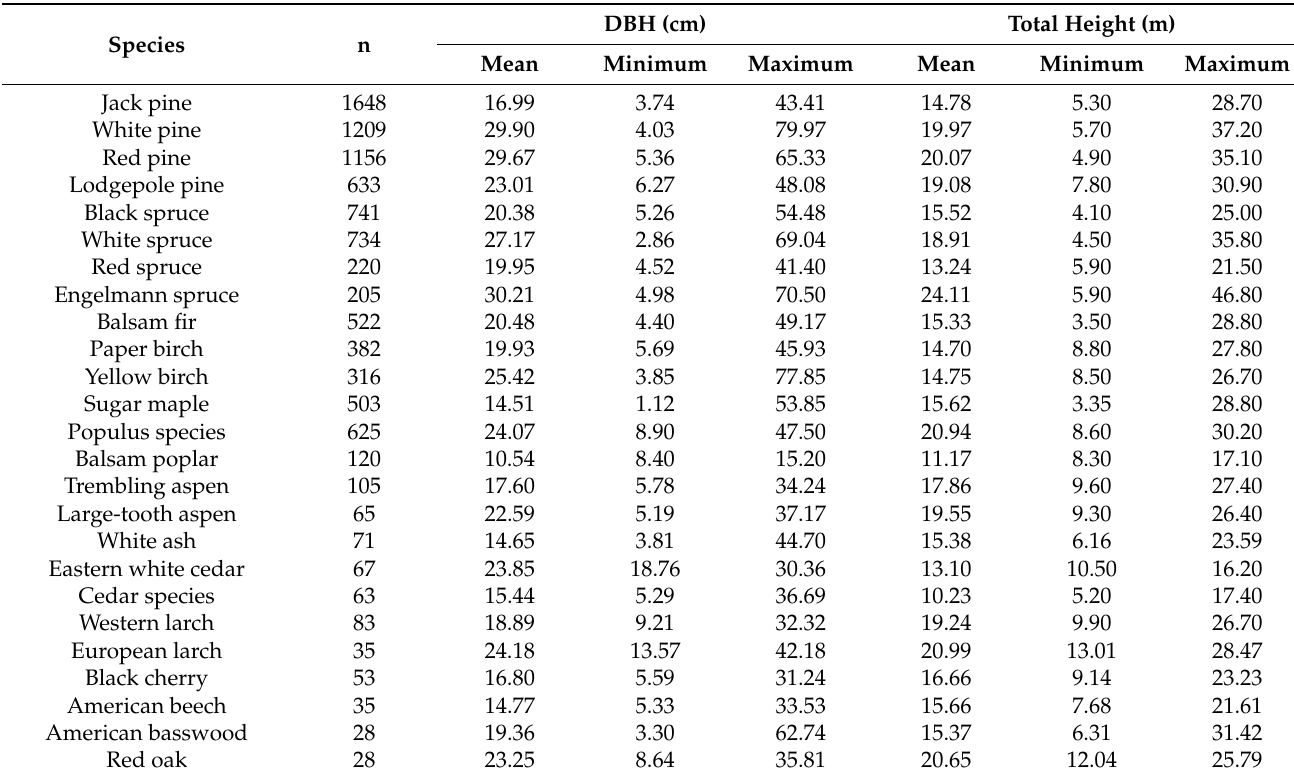
Table 1. Summary statistics for diameter at breast height (DBH) and total height of the trees used to develop volume equations in this study (n = number of sampled